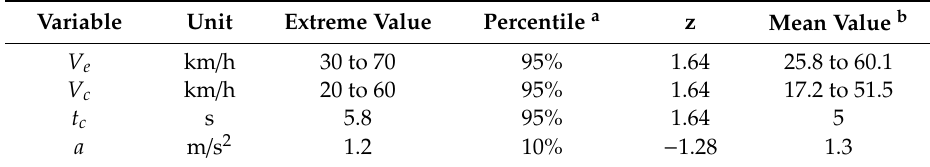
Table 3. Selected values of various random